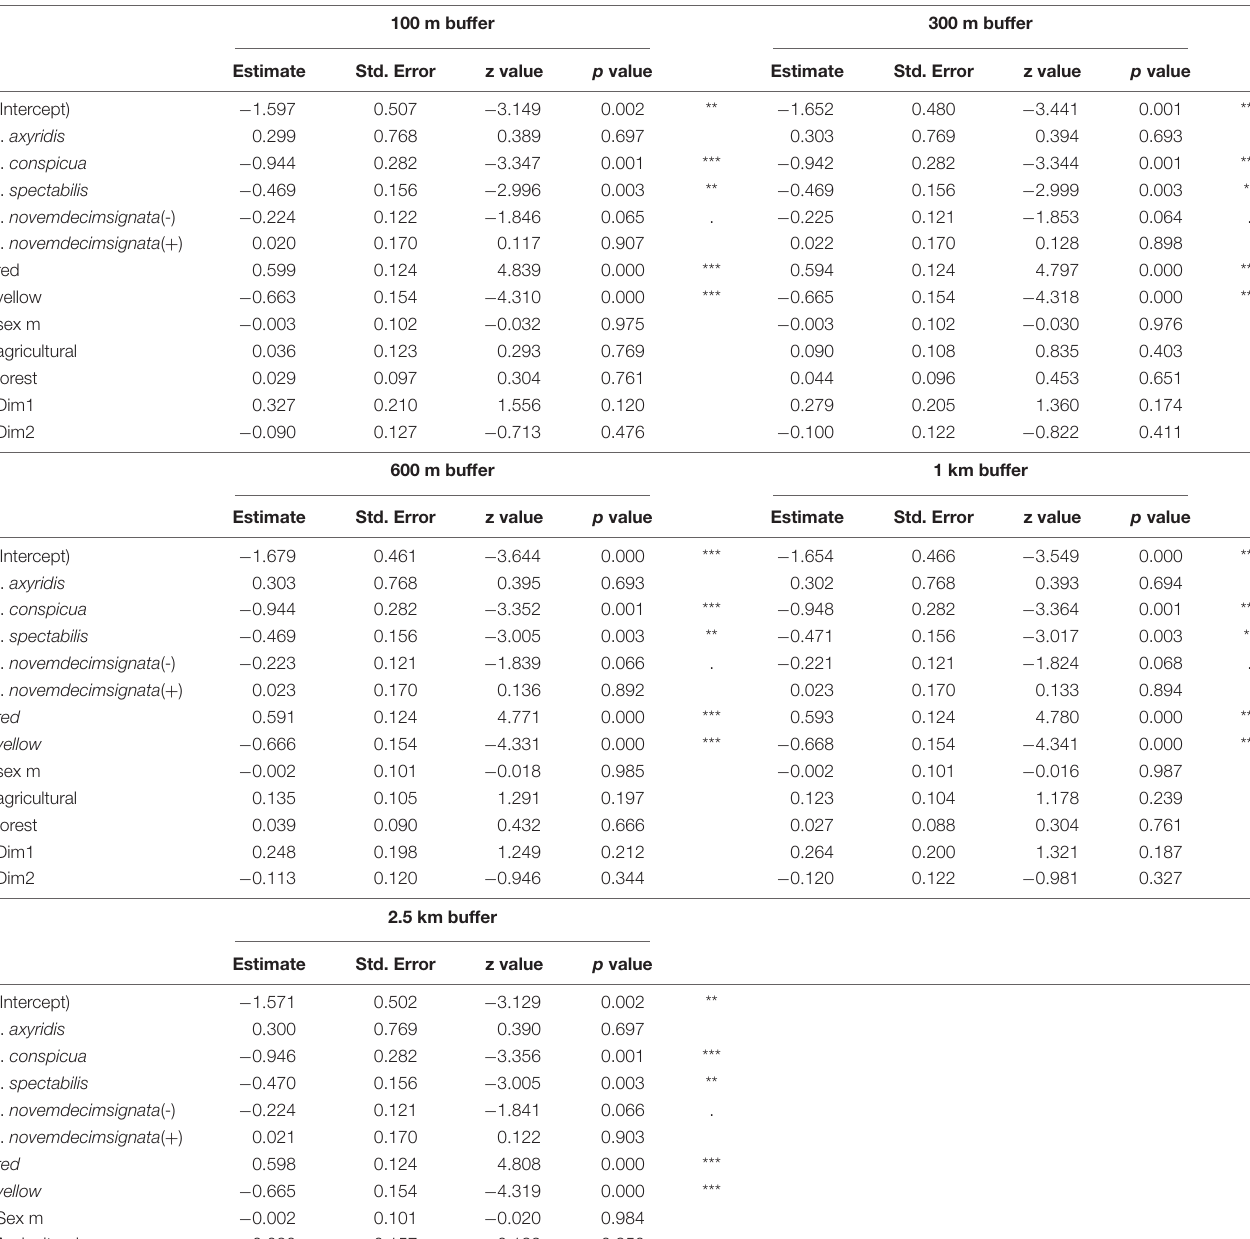
TABLE 2 | Obtained parameters of each candidate model addressing the prevalence of infection by Hesperomyces virescens for different buffer radii (100 m, 300 m, 600 m, 1 km, 2.5